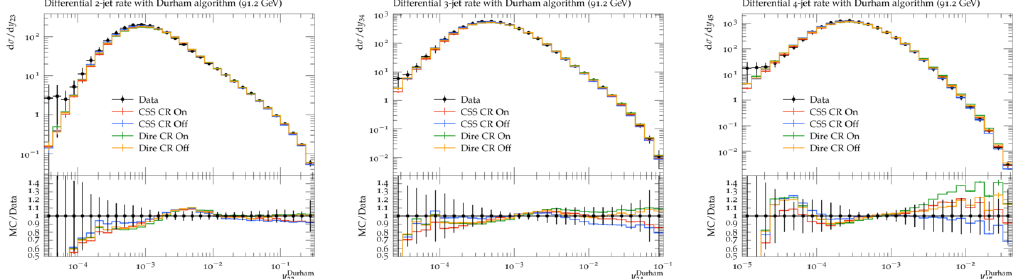
Figure 6: Differential jet rates in the Durham scheme, in e − e + → hadrons at centre- of-mass energies of 91.2 GeV. S HERPA results are compared with data from a combined J ADE -O PAL publication [ 51 ] , for (from left to right) the differential 2 → 3, 3 → 4, and 4 → 5 jet